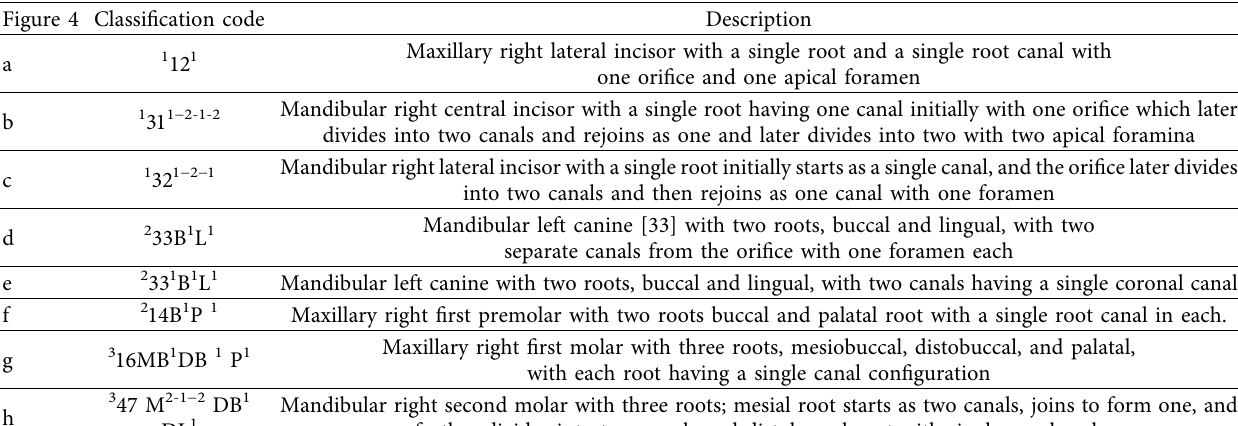
Table 1: Examples of different tooth morphologies following Ahmed et al.’s classification. Figure 4 Classification code